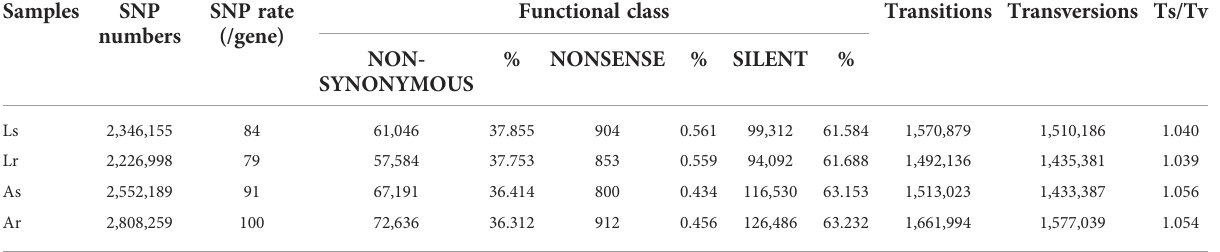
TABLE 1 Statistics of SNPs identi fi ed in the larval and adult populations.